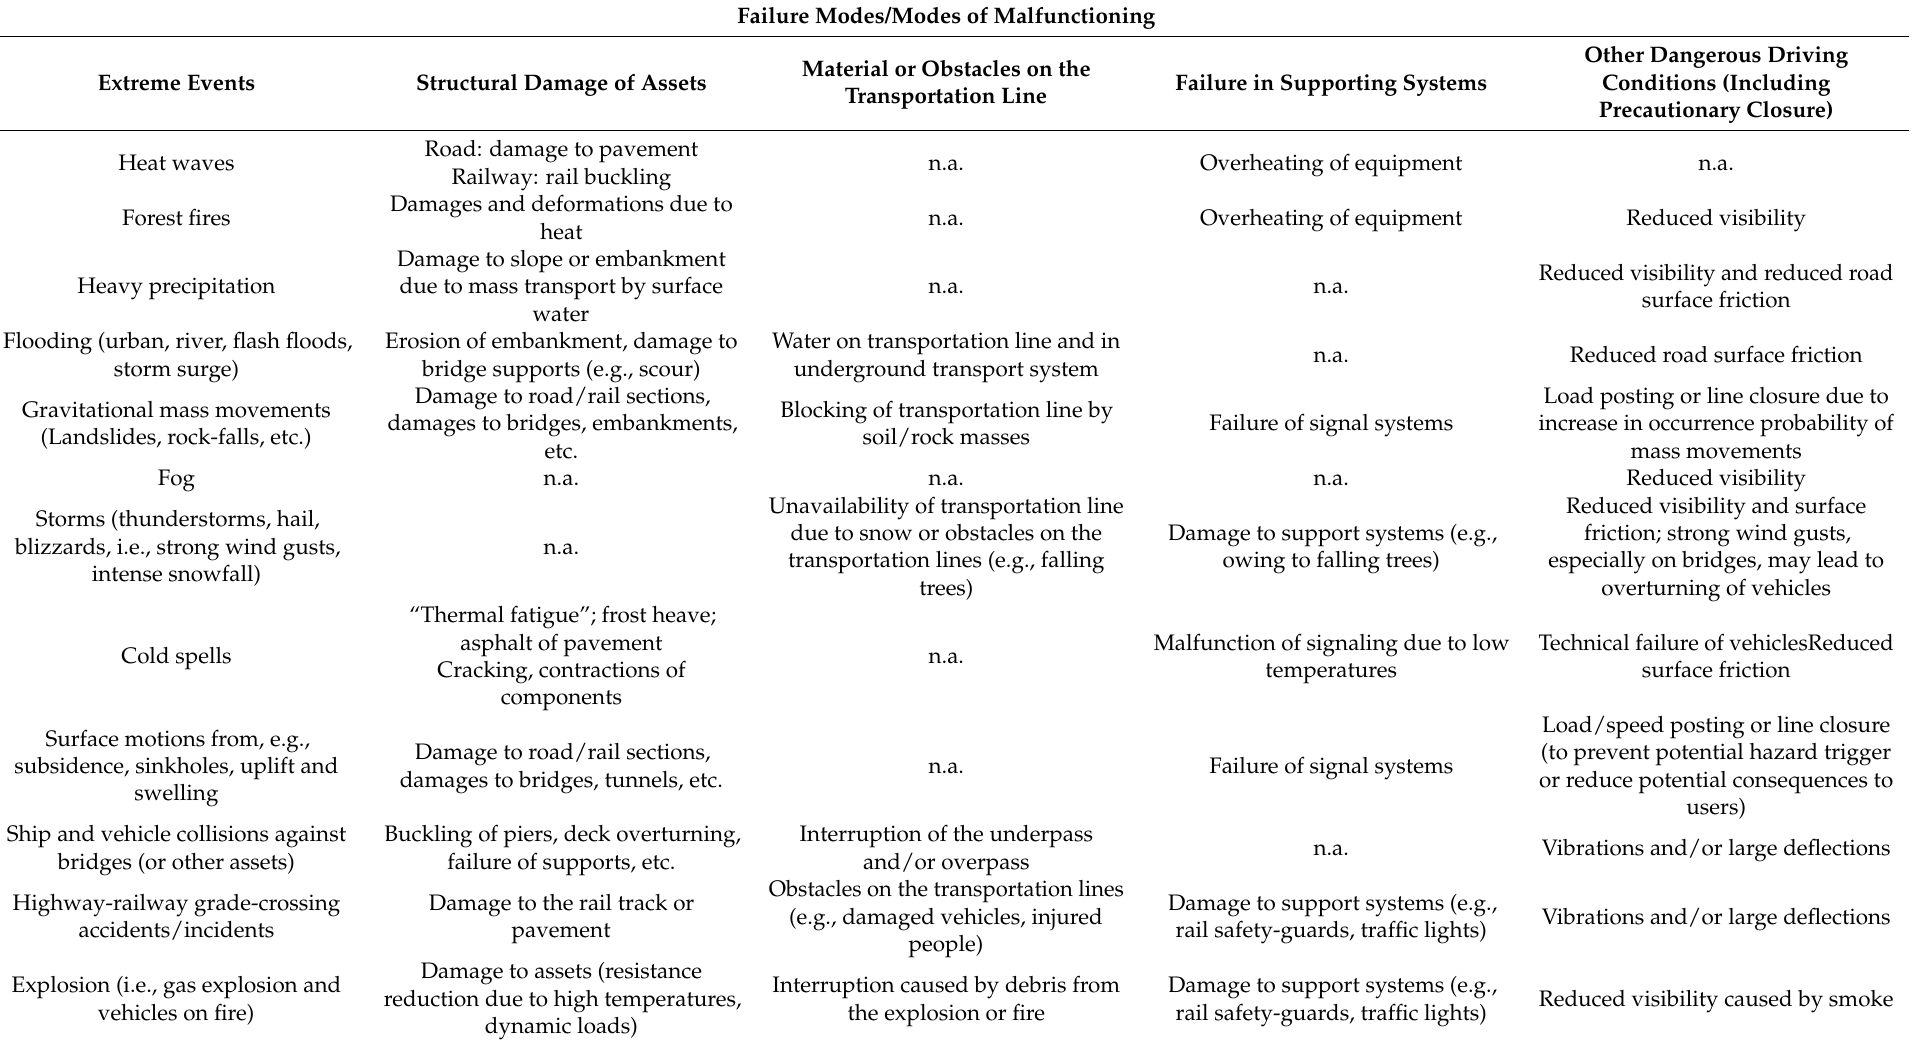
Table 1. Overview of failure modes/modes of malfunctioning triggered by extreme events, classified into main categories (n.a. = not